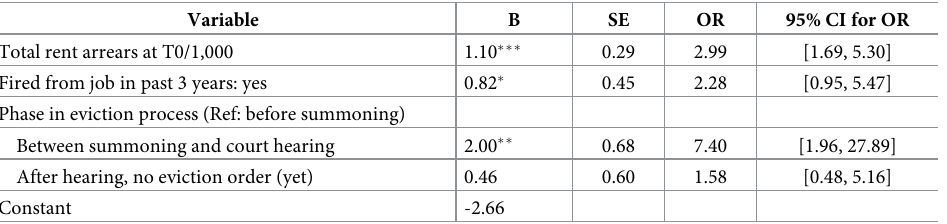
Table 4. Final multiple logistic regression model predicting receiving an eviction order for single tenants (N =